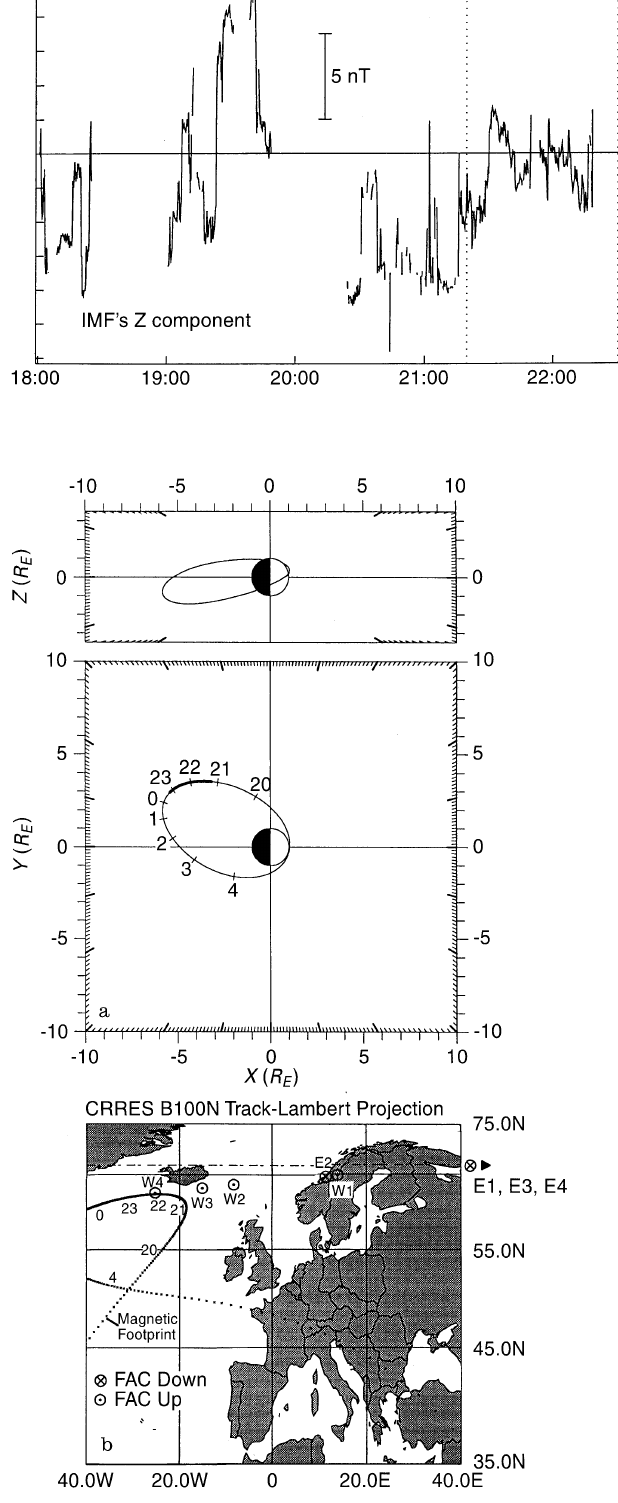
Fig. 4a, b. Orbital parameters for CRRES’ orbit 548; a in GSM coordinates. The solid line marks the orbit segment for the time spanned by Fig. 5; b CRRES’ northern magnetic footprint for orbit 548. Also plotted are the positions of the substorm electrojet as it progressed westwards. W1 and E1 are the westward and eastward ends of the current wedge for 21 (cid:51)(cid:57) UT; W2 and E2 are for 21 (cid:52)(cid:52) UT; W3 and E3 are for 21 (cid:53)(cid:50) UT; and W4 and E4 are for 21 (cid:53)(cid:54)